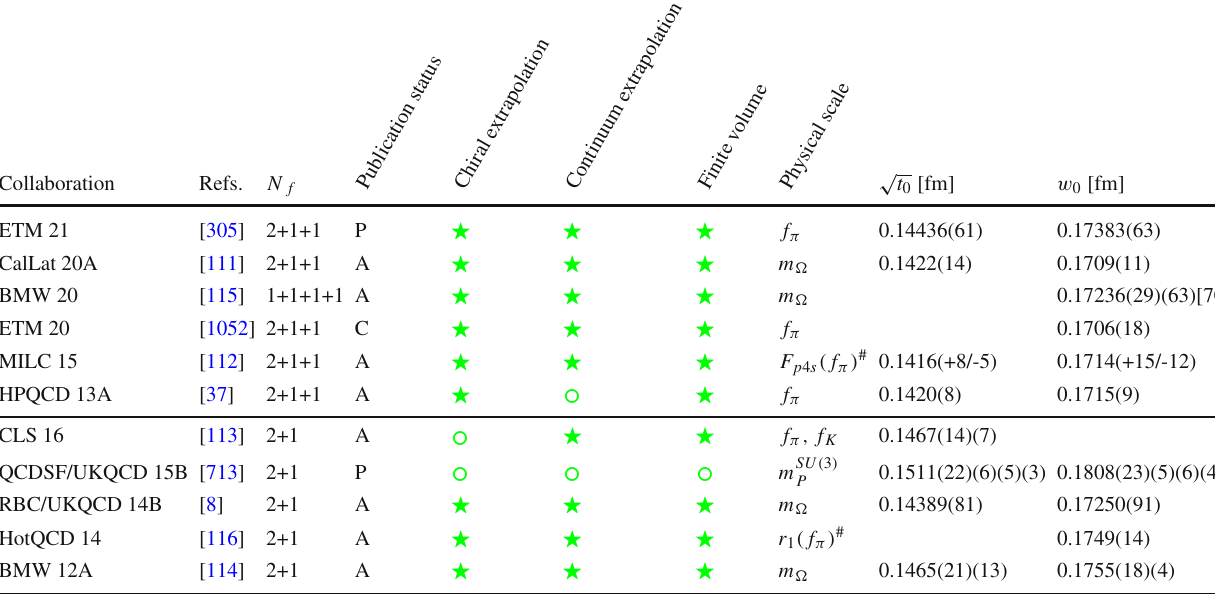
Table 76 Results for gradient flow scales at the physical point, cf. Eq. (469). Note that BMW 20 [115] take IB and QED corrections into account. Some additional results for ratios of scales are: ETM 21 [305]: t 0 /w 0 = 0 . 11969 ( 62 ) fm